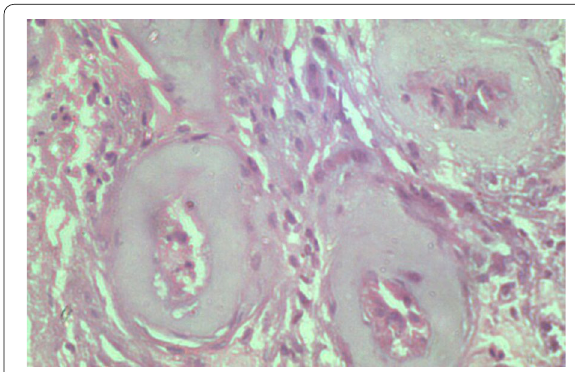
Fig. 1 Testicular histopathology showing tubular fibrosis and hyalinization with leydig cell